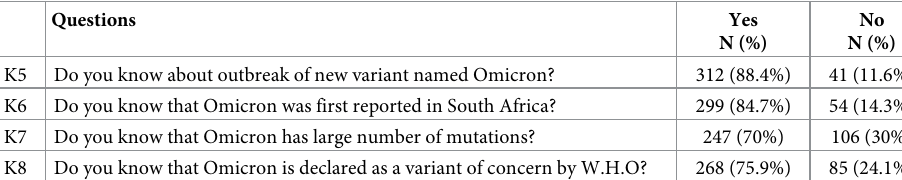
Table 4. Respondents’ knowledge about Omicron (B.1.1.529)